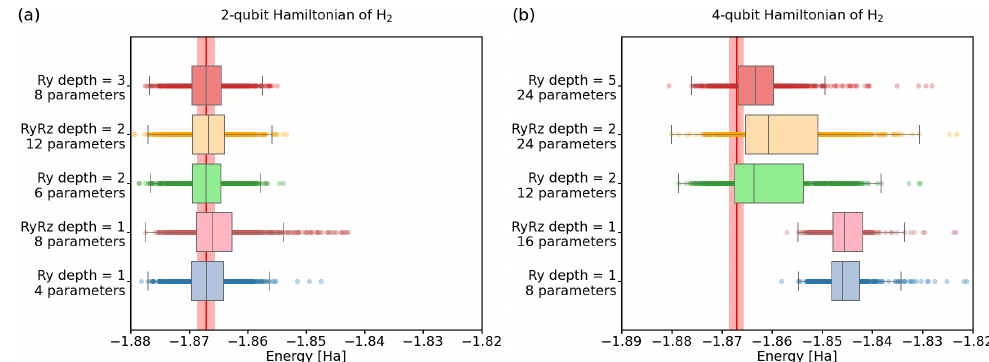
Figure 5. Comparison of the VQE energies for H 2 using the R y and R y R z variational circuit forms. We used a noiseless quantum simulator and 4096 shots; ( a ) 2-qubit Hamiltonian. ( b ) 4-qubit Hamilto- nian. The red line represents the physical ground-state energy ( − 1.86712 Hartree) and the light-red background represents the chemical accuracy ( ± 0.0015